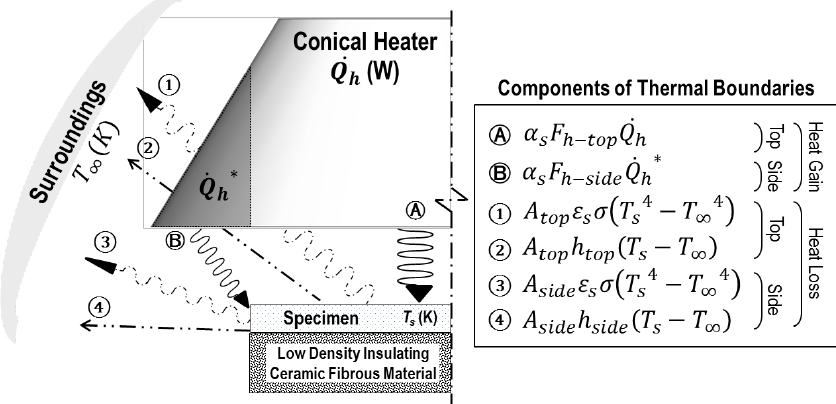
Figure 2. A schematic of the thermal boundaries of a specimen tested with the cone calorimeter.